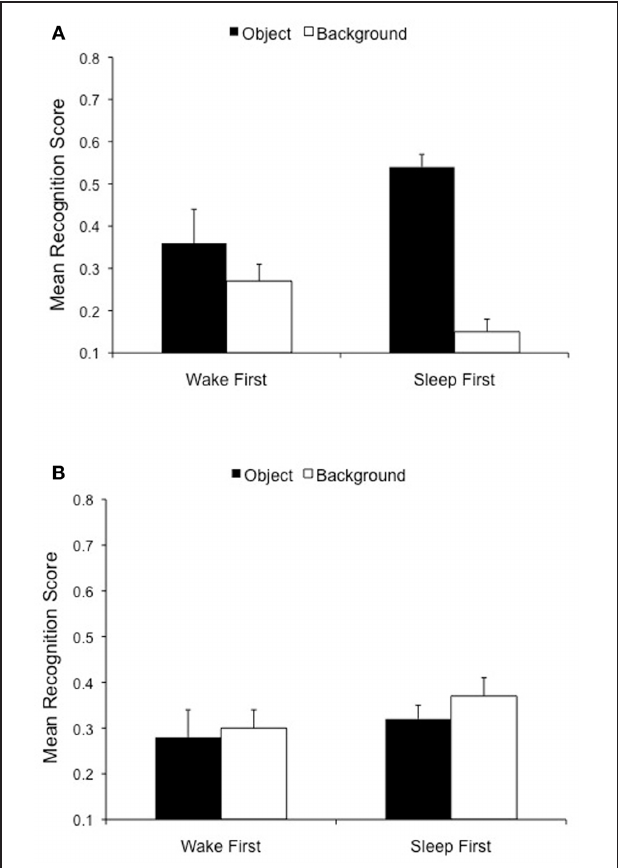
FIGURE 5 | Twenty-four hours delay memory performance is modulated by the placement of sleep. (A) Negative objects are better remembered in the Sleep First ( p < 0 . 05), compared to the Wake First, condition, but the opposite is true for associated backgrounds ( p < 0 . 05). (B) The Sleep First and Wake First groups do not differ on memory for any component of the neutral scenes.